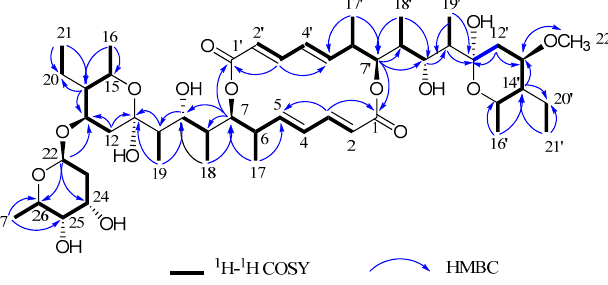
Figure 2. Selected HMBC and COSY correlations of compound 1 in CDCl 3 . Table 1. 13 C- and 1 H-NMR data (500 MHz, CDCl 3 ) for 1